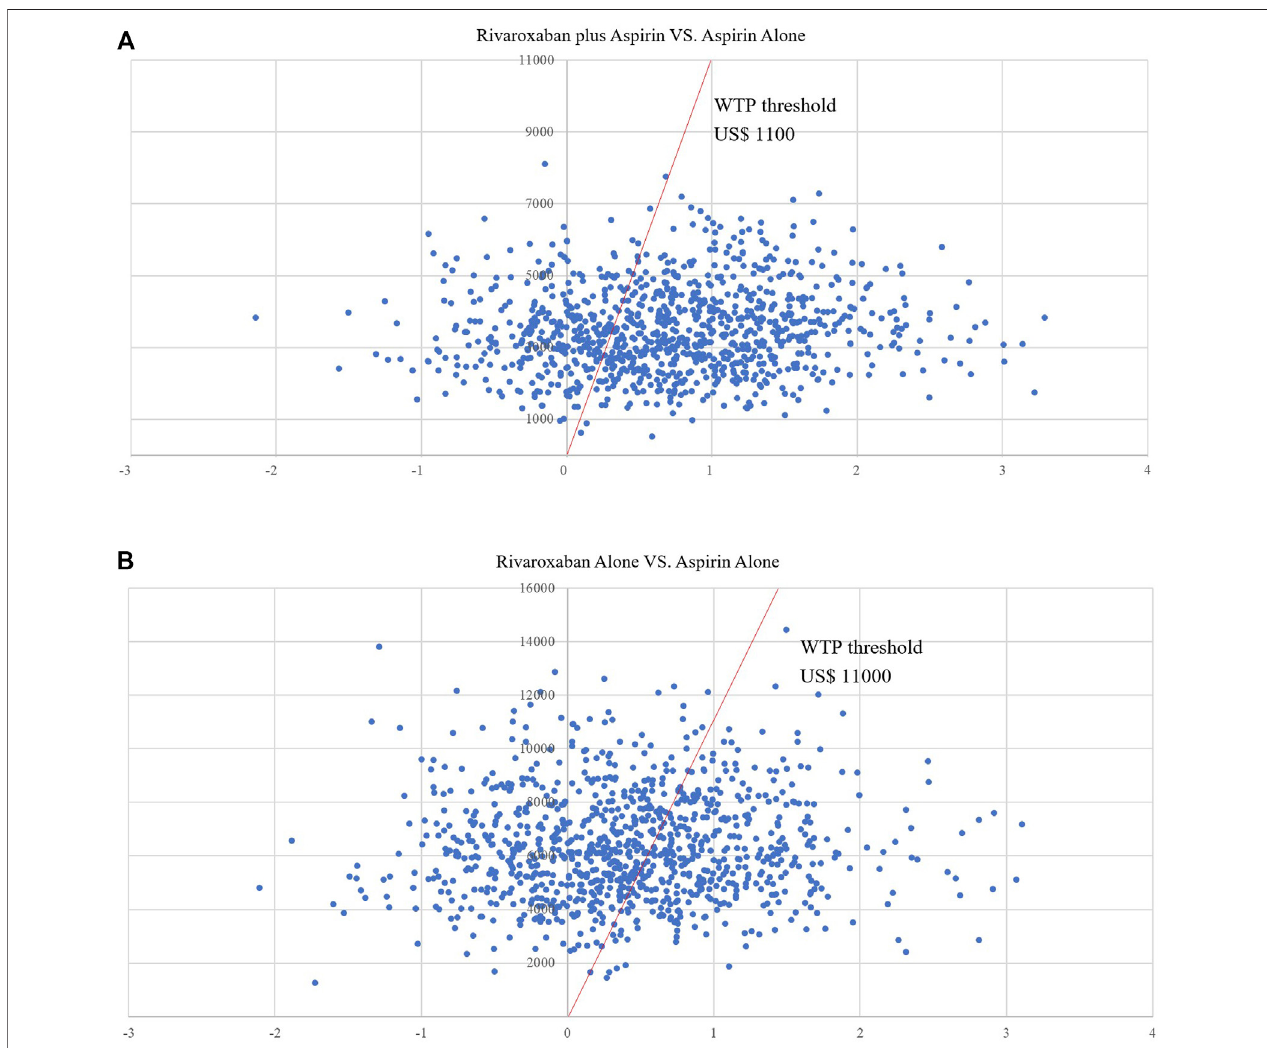
FIGURE 5 | (A) Scatter plot showing the incremental costs and incremental quality-adjusted life-year of a thousand simulations for Low-does rivaroxaban plus aspiringroupvs.Aspirinalonegroup. (B) Scatterplotshowingtheincrementalcostsandincrementalquality-adjustedlife-yearofathousandsimulationsforRivaroxaban alone group vs. Aspirin alone